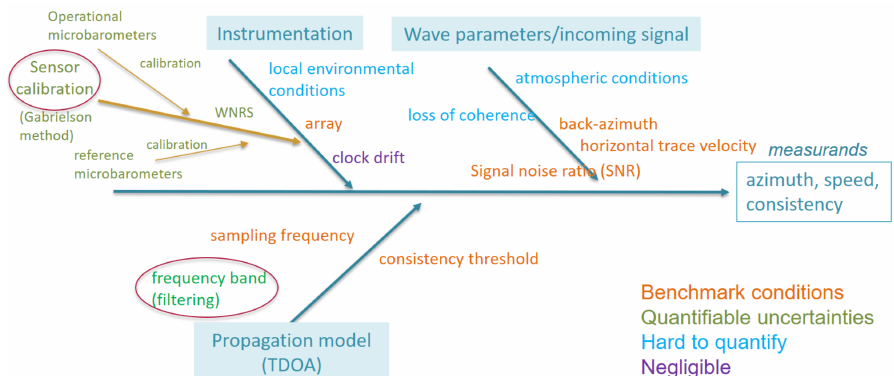
Figure 4. Ishikawa diagram for back azimuth and trace velocity. The red circles indicate the quantifi- able uncertainty sources that are considered in this